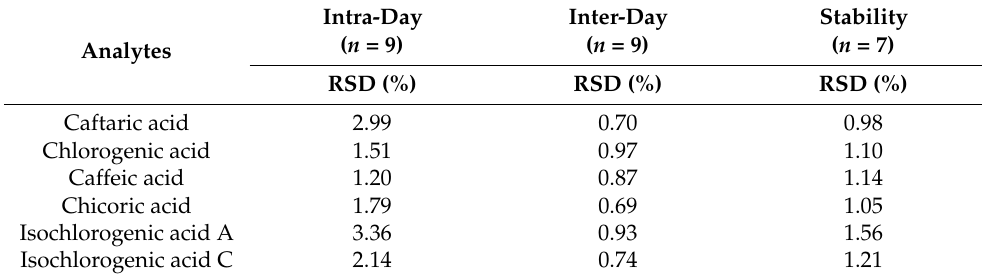
Table 8. Precisions of the quantification method